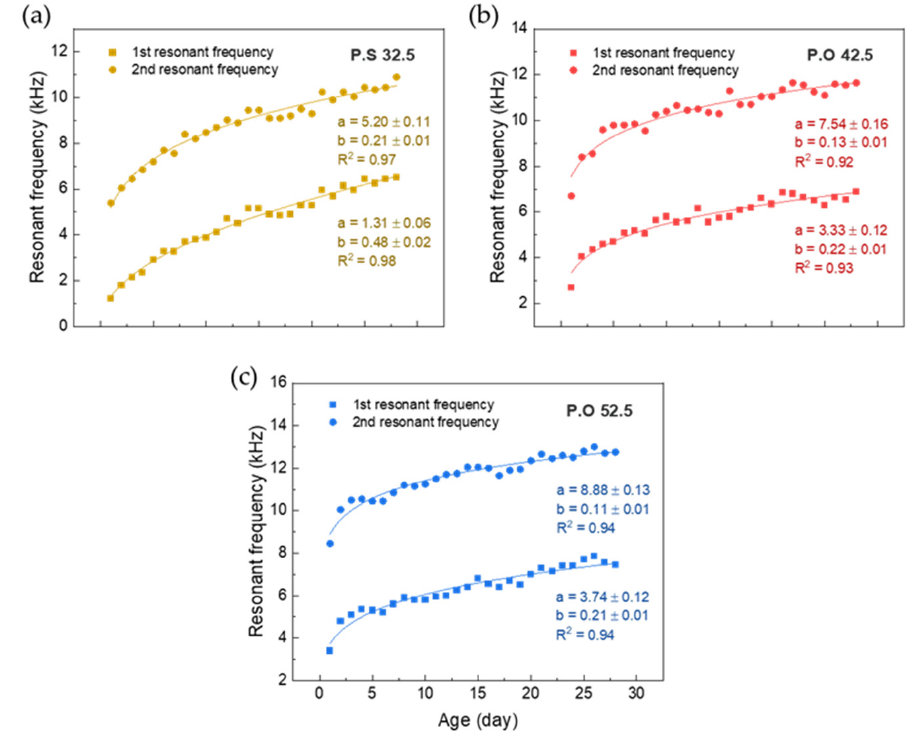
Figure 6. Experimental resonant frequency: ( a ) Resonant frequency of P.S 32.5 variation during time; ( b ) Resonant frequency of P.O 42.5 variation during time; ( c ) Resonant frequency of P.O 52.5 variation during the time.